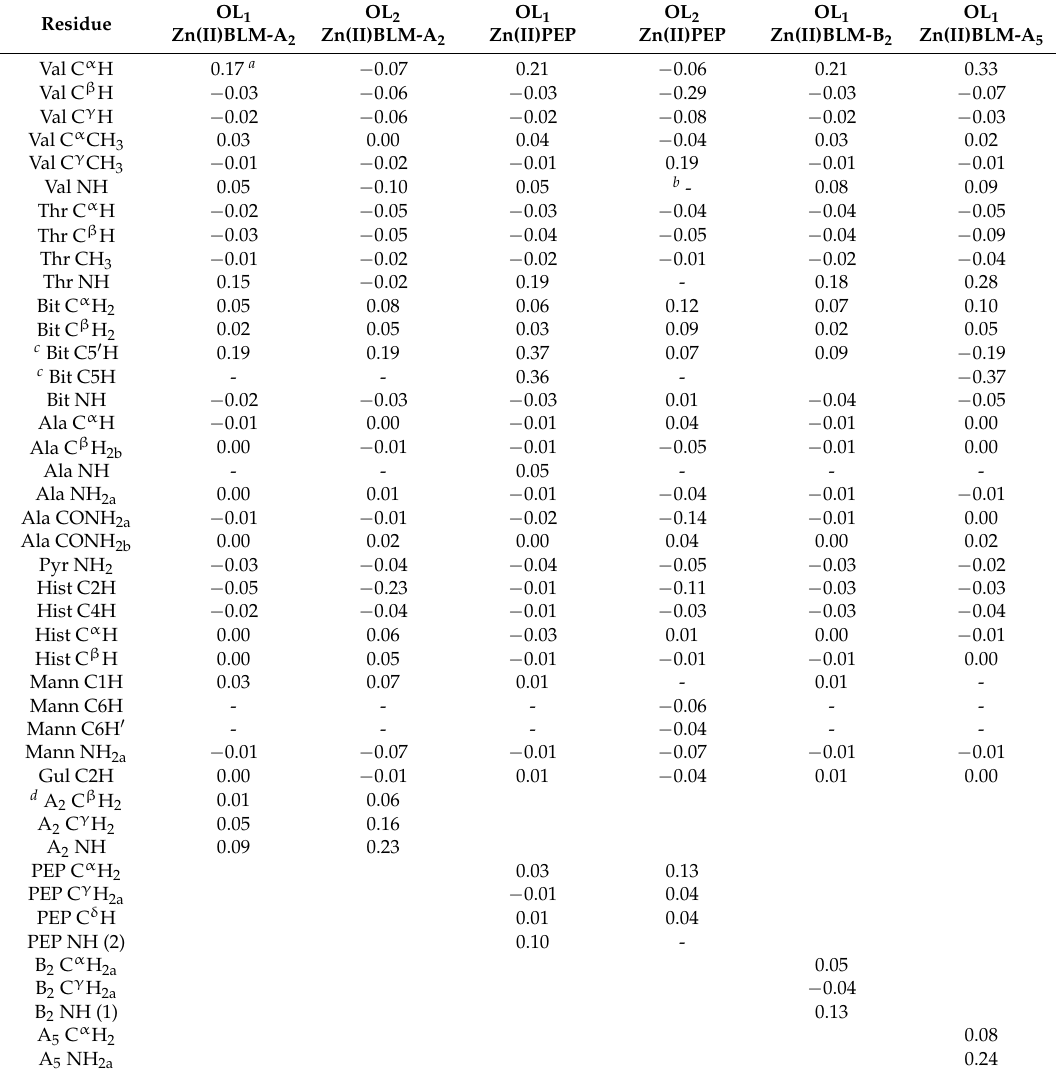
Table 1. Chemical shift differences ( ∆ δ ) between free and OL-bound Zn(II)BLM for spectra acquired in H 2 O at 5 ◦